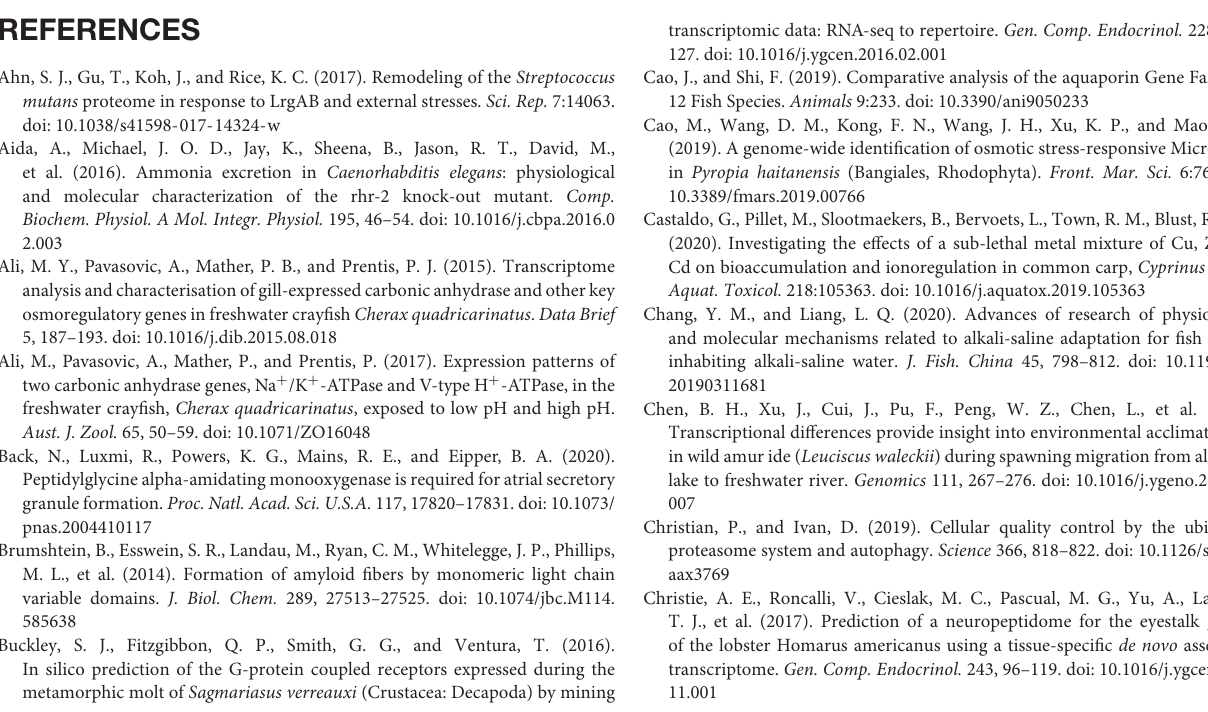
Supplementary Figure 2 | GO and KEGG annotation results of the proteome. (A) GO annotation of differentially expressed proteins (DEPs). (B) KEGG annotation of DEPs. Supplementary Figure 3 | Transcriptome and proteome expression correlation scatter diagram. (A) Expression correlation scatter plot of 0 vs. 12 h. (B) Expression correlation scatter plot of 0 vs. 36